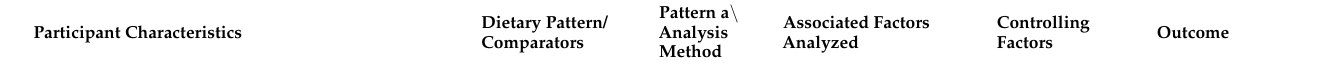
Table 3. Characteristics of cross-sectional studies analyzing factors associated to fruits and vegetables